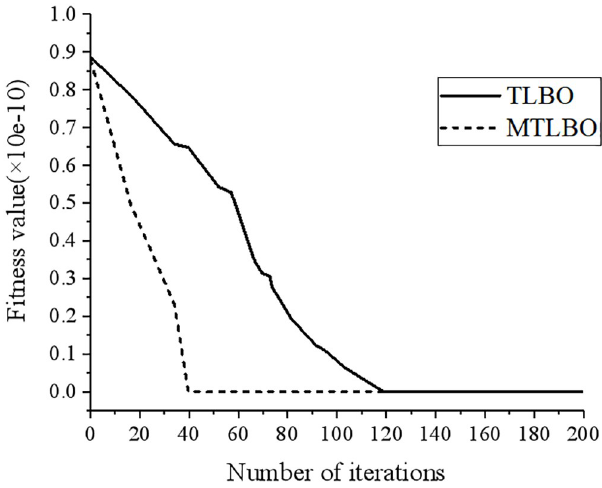
Fig 5. Convergence curves of the two algorithms in the Griewank